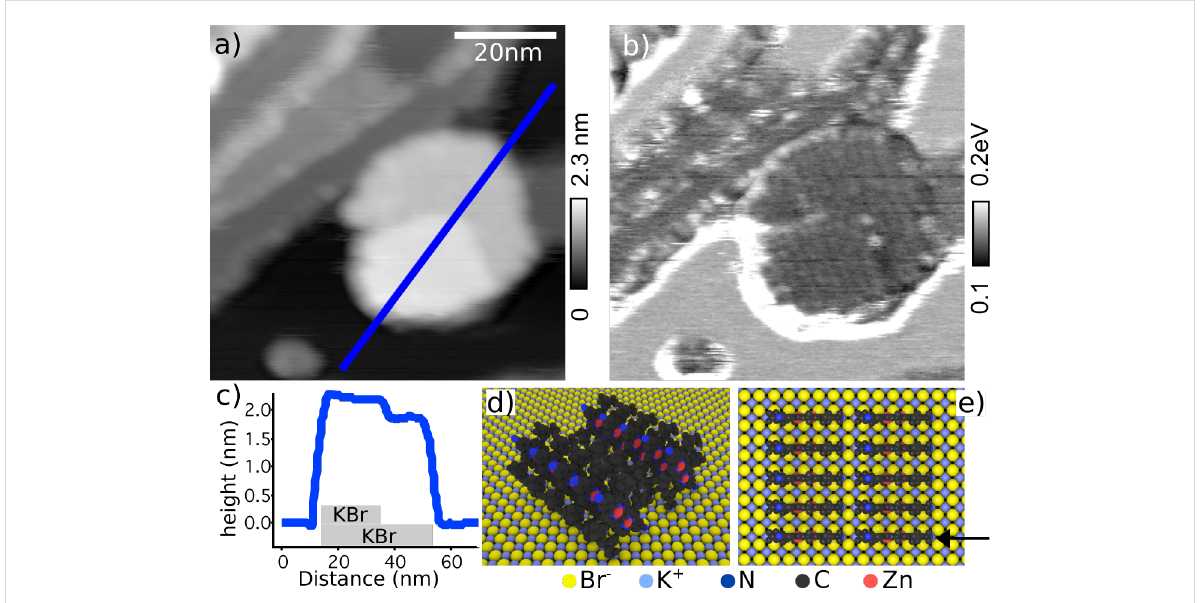
Figure 5: a) Topography image of a diporphyrin island on KBr(001). b) Corresponding dissipation image. c) Island profile, blue line in a). Scheme of the molecular arrangement in side view d) and in top view e). Black arrow point toward CN group anchored to K + ions. Parameters: A = 5 nm, Δ f = − 8